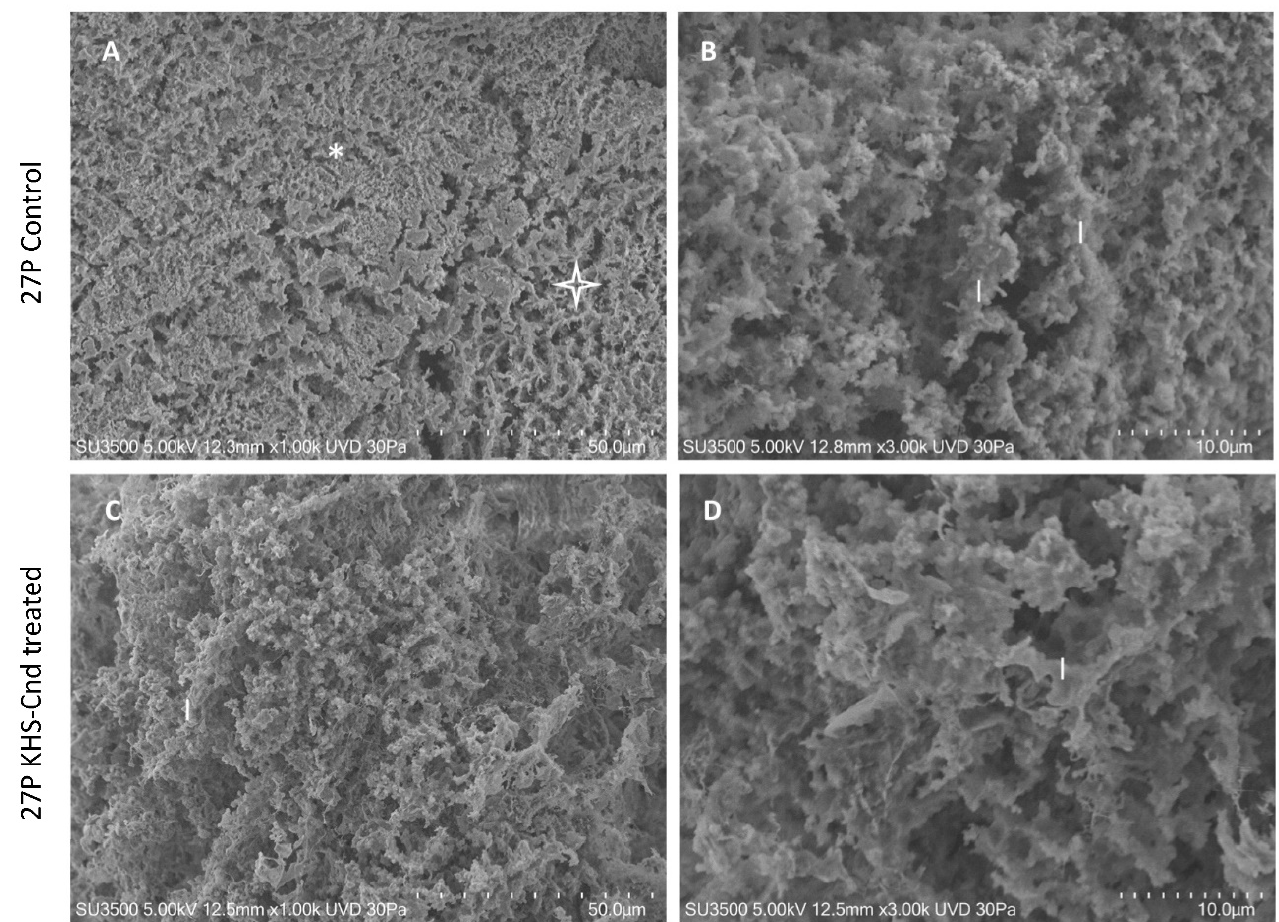
Figure 4. VP-SEM images of untreated P. aeruginosa 27P ( A , B ). ( A ) At low magnification (1.00 K), ECM was organized in both compact (asterisk) and spongy areas (star). ( B ) At higher magnification (3.00 K), ECM was formed by interconnected laminae (l), rather than trabeculae. VP-SEM images of P. aeruginosa 27P treated with KHS-Cnd ( C , D ). ( C ) At low magnification (1.00 K), the laminae forming ECM 3D network (l) appeared curly, as in the control sample. ( D ) Higher magnification (3.00 K) showed that the laminae (l) had the same shape as in the untreated sample. of P. aeruginosa 27P, we used the Hitachi Map 3D Software (v.8.2., Digital surf, Besançon,